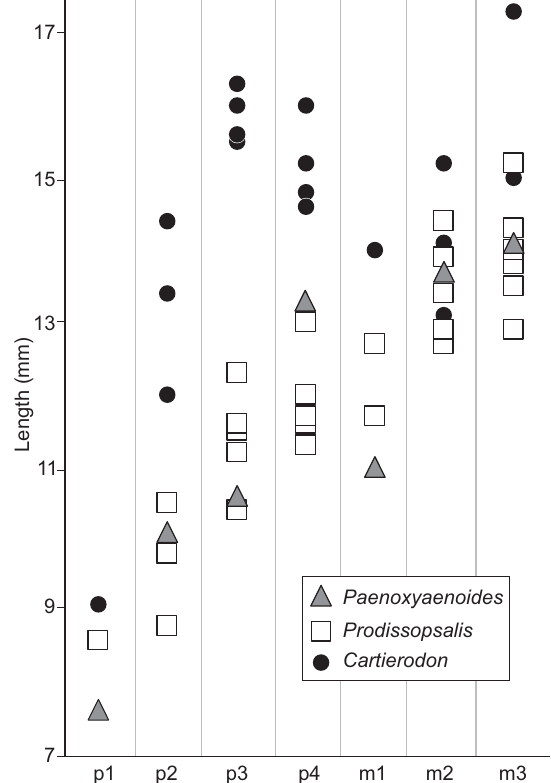
Fig. 3. Comparison of the length of the lower premolars and molars of Cartierodon egerkingensis gen. et sp. nov. from the Eocene of Switzerland, Egerkingen γ (MP13?); Prodissopsalis eocaenicus from the Eocene of Switzerland, Geiseltal-Obere Mittelkohle (MP12) and Geiseltal-Untere Mittelkohle (MP13) (based on Lange-Badré and Haubold 1990: table 3); and Paenoxyaenoides liguritor from the late Eocene of France, Quercy Phosphorites (based on Lange-Badré 1979: table